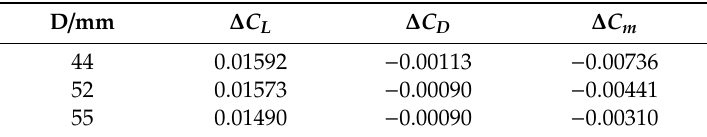
(D = 44 mm / 52 mm / 55 mm, Ma = 0.75, α = 0 ◦ ).